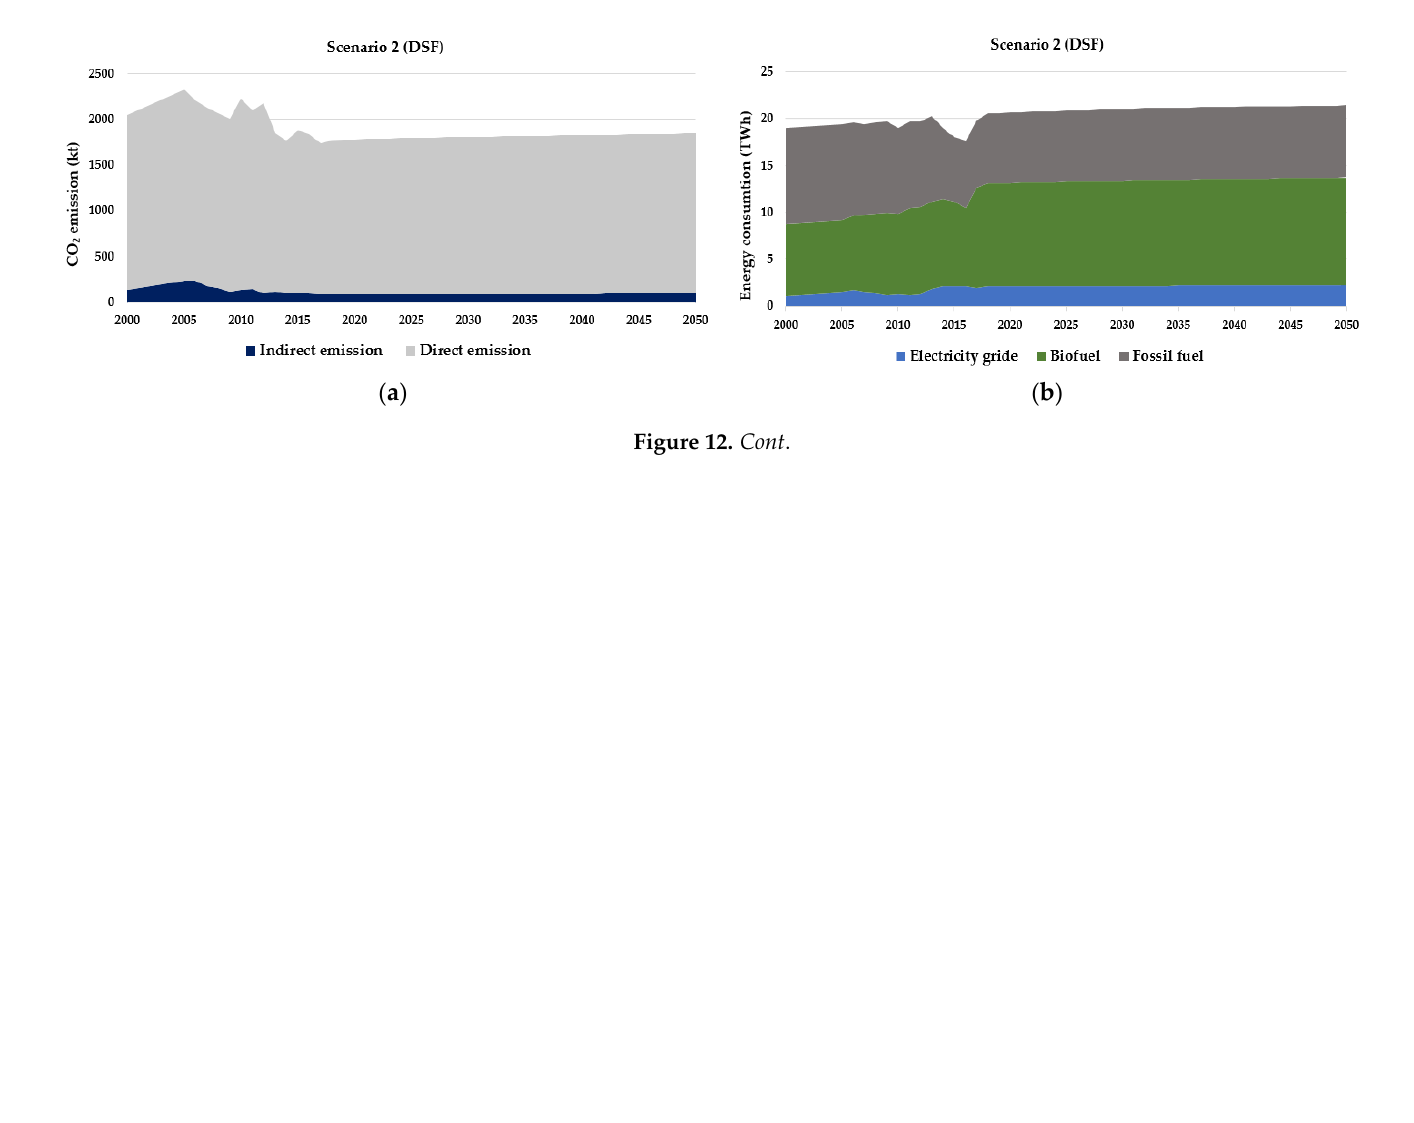
Figure 11. Projection of CO 2 emission by alternative scenarios with DEH technology.